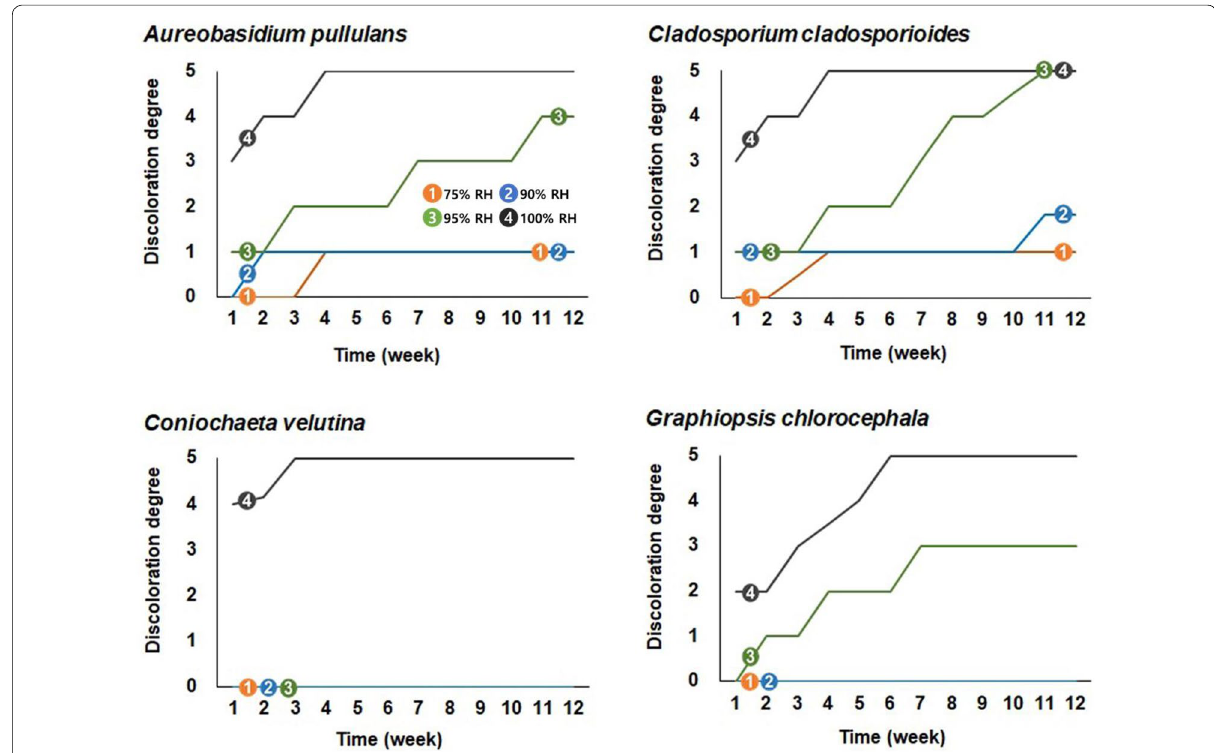
Fig. 3 Effect of the RH on wood discoloration by mold and stain fungi at 25